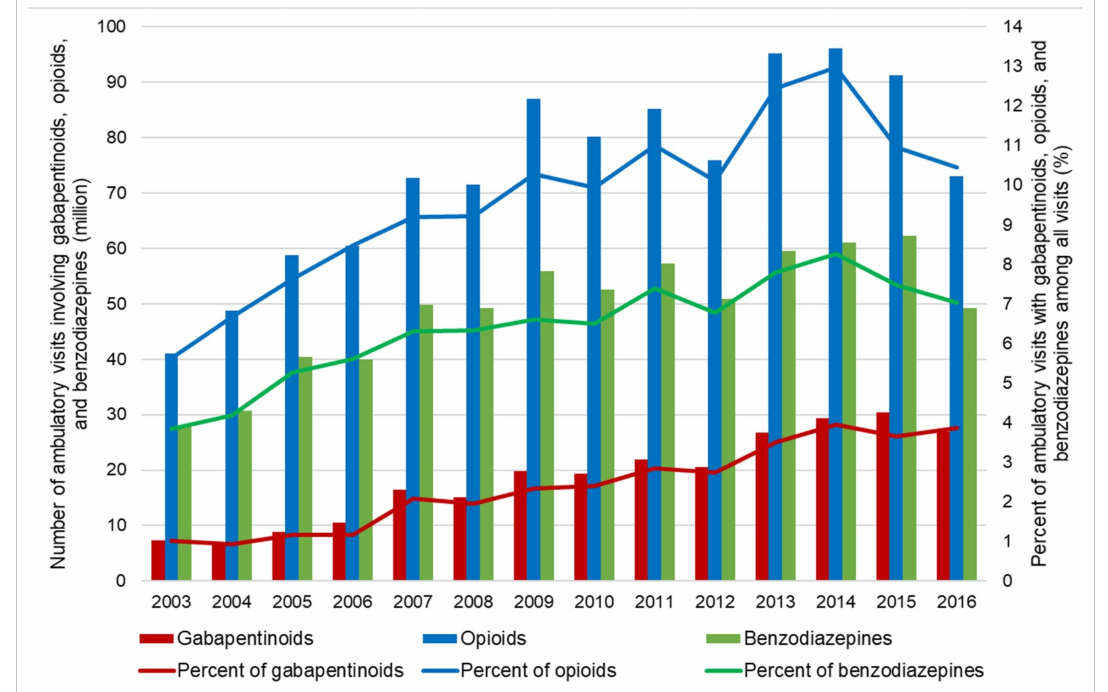
Figure 1. Trends in use of gabapentinoids, opioids, and benzodiazepines in the US ambulatory care settings: 2003–2016 National Ambulatory Medical Care Survey (NAMCS).